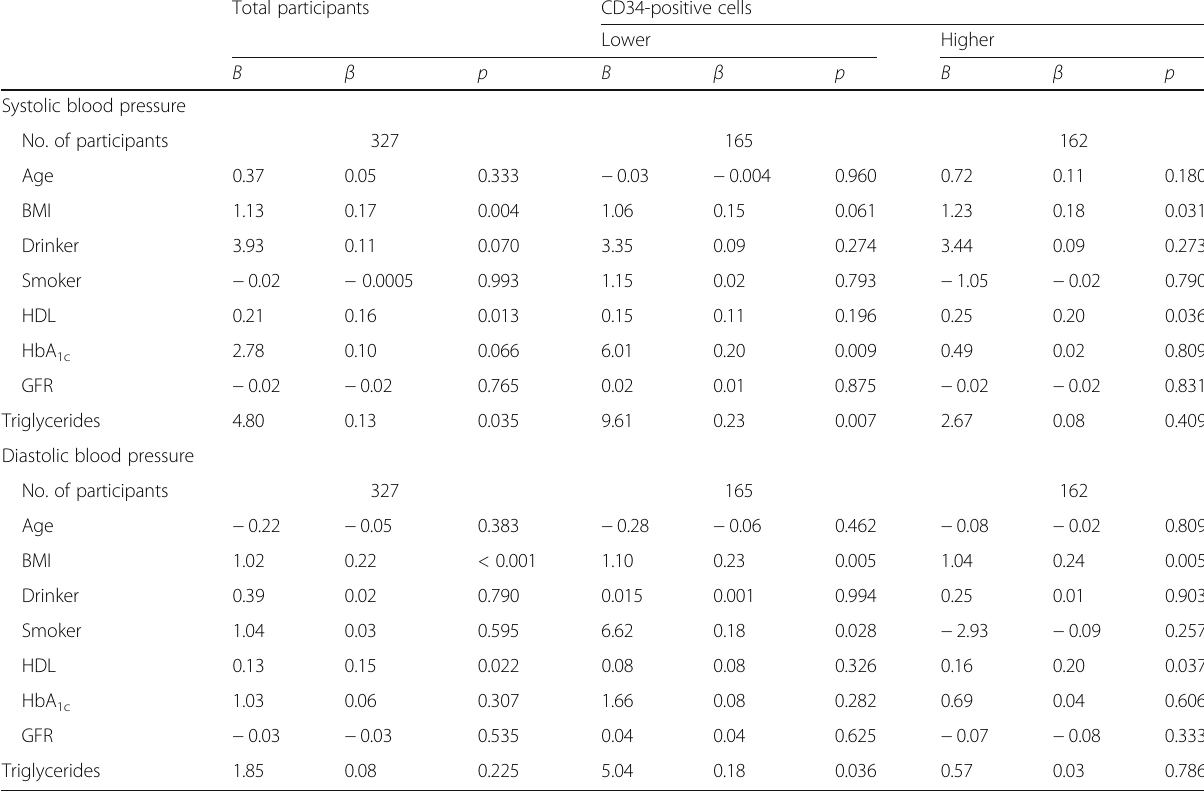
Table 3 Multiple linear regression analysis of blood pressure (systolic and diastolic) with relevant factors adjusted for confounding factors